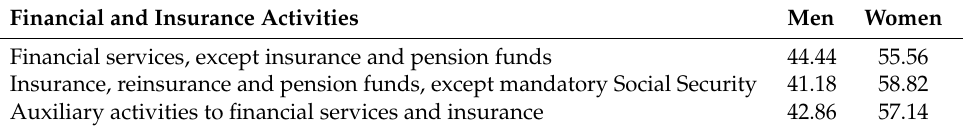
Table 6. Percentage distribution of employment by sectors in the activity branch Financial and insurance